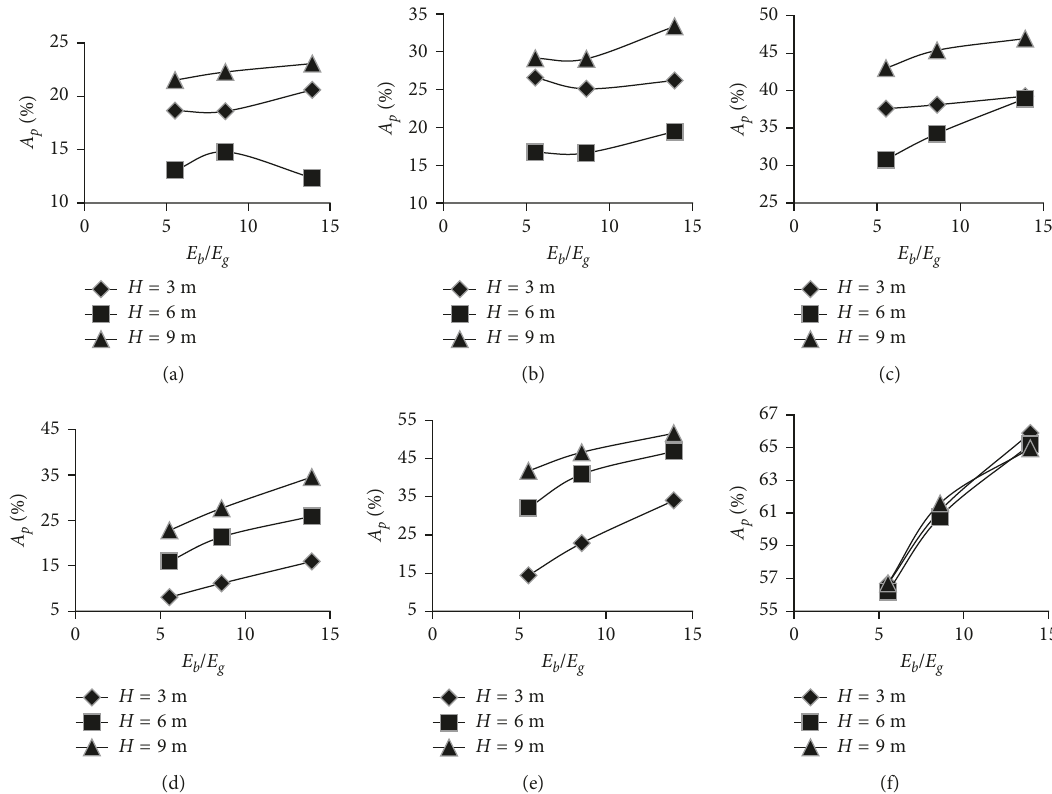
Figure 12: Influence of relative stiffness of geofoam ( E and (d, e, and f) nonyielding retaining walls. (a) t / H